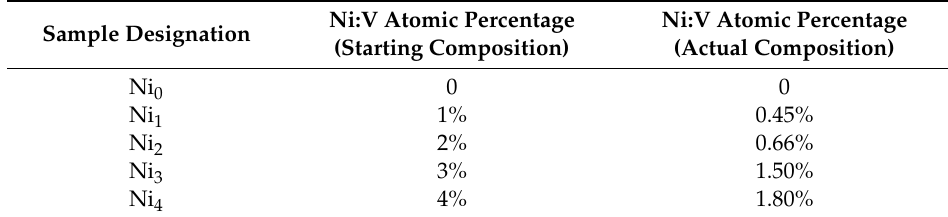
Table 1. The theoretical atomic percentage and actual atomic percentage of the samples.